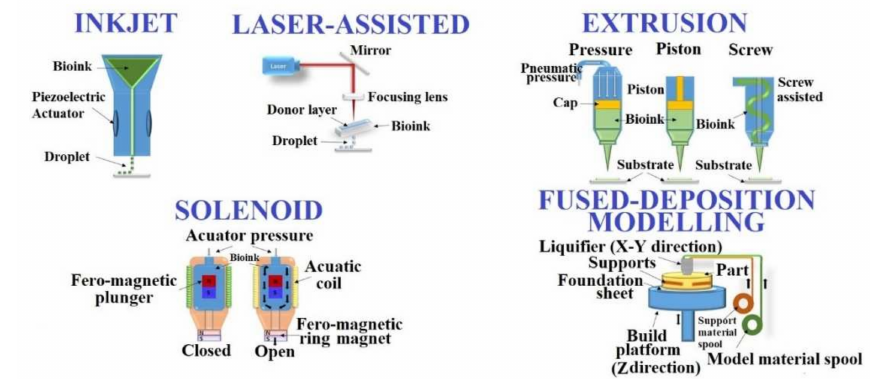
Figure 10. Examples of bioprinting techniques (reproduced after